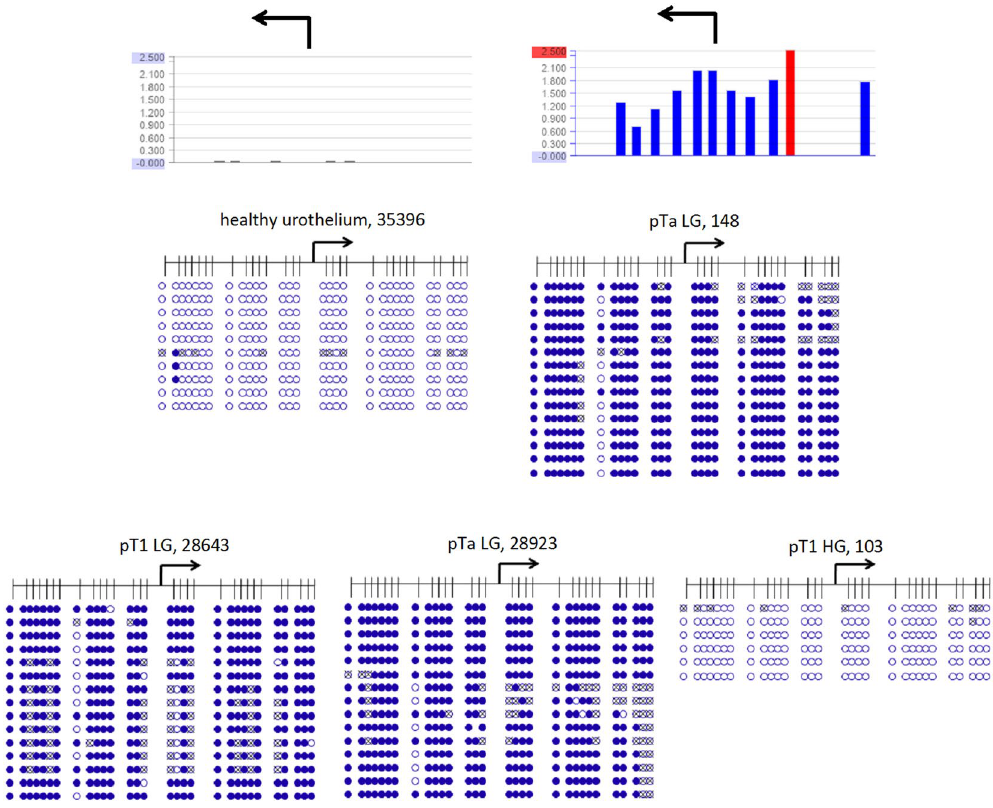
Figure 3. Detailed analysis by bisulfite sequencing of CpG island methylation patterns within 5 ′ regulatory region of AHCY gene in early urothelium carcinoma. Stage and grade of UC tissue specimens with sample IDs (Table 1) are depicted above the panels. Exemplified above the first two panels, two corresponding array results are shown by bar plots. Each blue bar represents a 75bp long CpG rich probe on the array. The high of a bar is proportional to methylation degree. Underneath the detailed CpG methylation profiles of the CpG rich 5 ′ regulatory region of AHCY gene are documented as they were revealed by bisulfite sequencing. Filled circles stand for methylated CpG dinucleotides. White circles stand for unmethylated CpG. Crossed out circles stand for undefined CpG methylation status. Arrows indicate the transcription start site of AHCY gene. The red bar within the above, right bar diagram indicates that the corresponding value is 3200 and thus beyond the